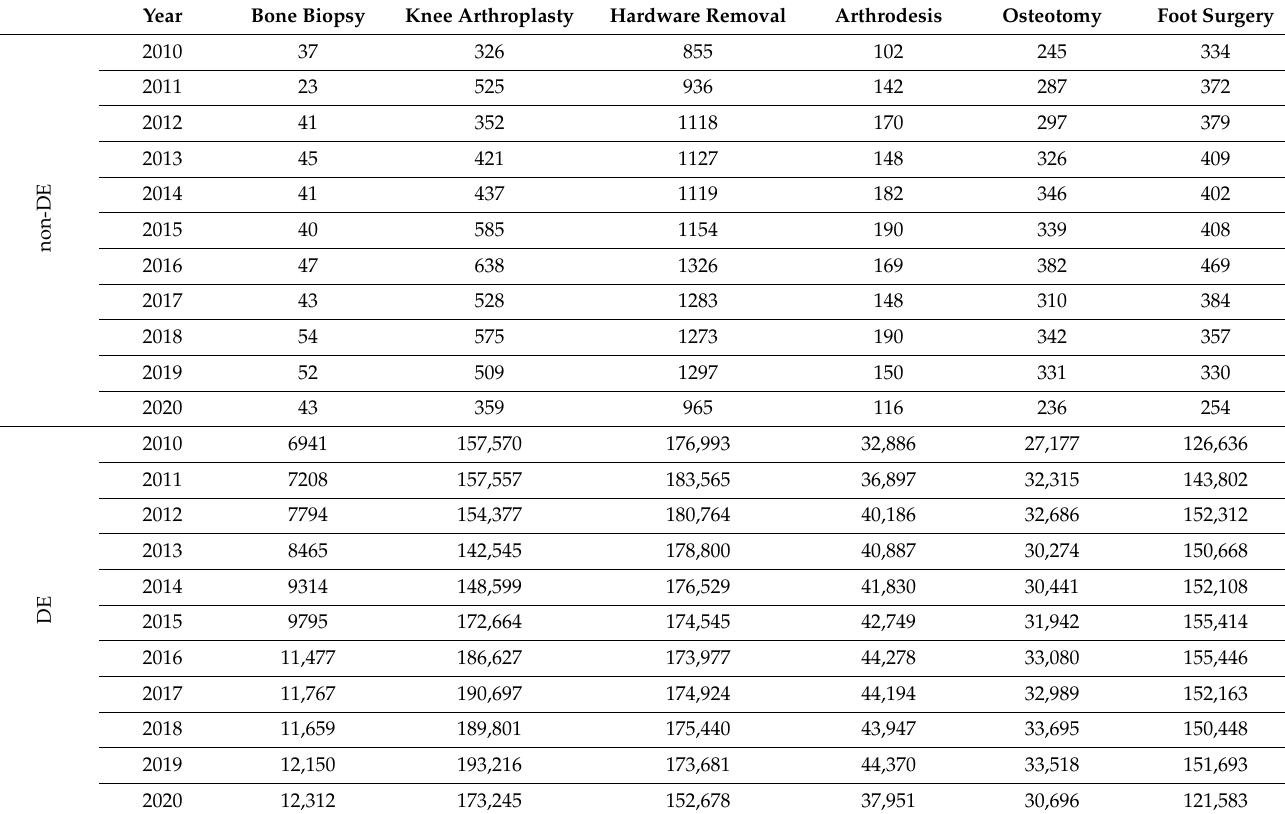
Table 4. Total count for surgical procedures for the years 2010–2020.